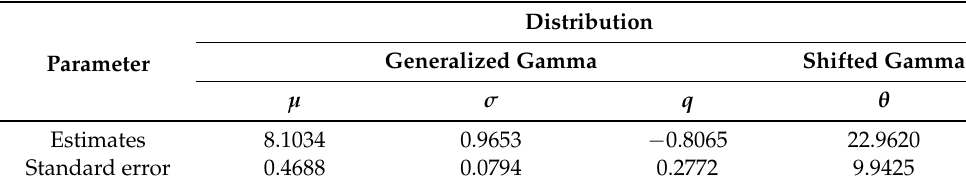
Table 9. Results of parameter estimation when variable selection is performed by applying the proposed model in